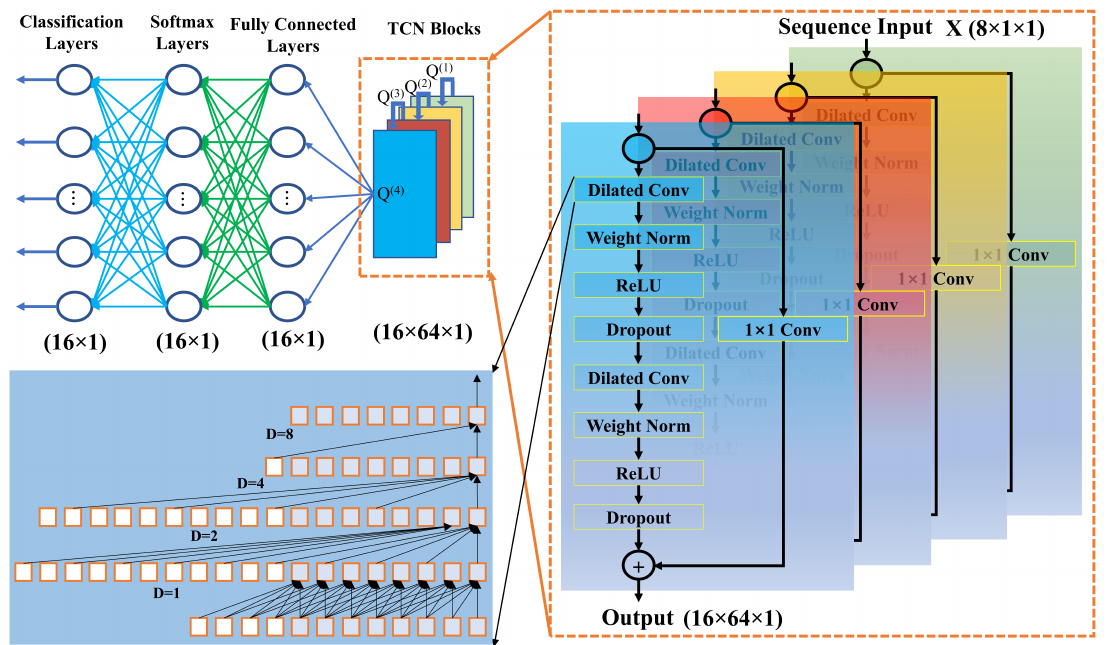
Figure 4. Block diagram of the proposed TCN-based demodulation technique at the receiver. The received input sequence is fed into the TCN network as (8 × 1 × 1) features and four TCN blocks employ Q ( 1 ) , Q ( 2 ) , Q ( 3 ) , Q ( 4 ) ; for the dilated convolution layer, we have used four dilation values (1, 2, 4, 8), kernel size 6, and 64 filters; the final output of Q ( 4 ) is connected to a fully connected layer with dimension (16 × 64 × 1), followed by a softmax layer with dimension (16 × 1), and a classification layer with dimension (16 ×